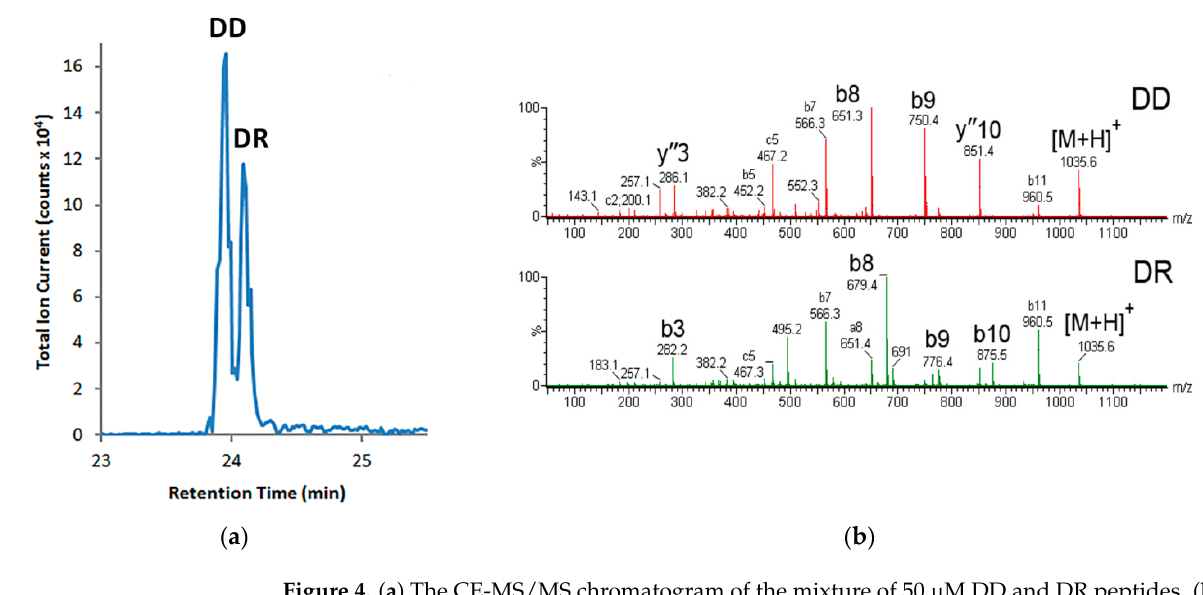
Figure 4. ( a ) The CE-MS/MS chromatogram of the mixture of 50 μ M DD and DR peptides. ( b ) The MS/MS scans of 23.94 min peak shows the characteristic ions of the DD peptide and 24.09 min peak shows the fragments of the DR peptide.